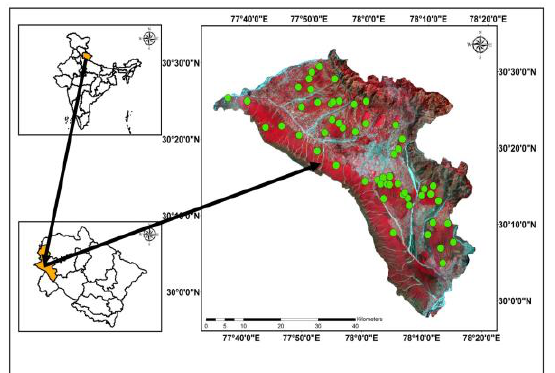
Figure 1. Location map of study area along with sampling points